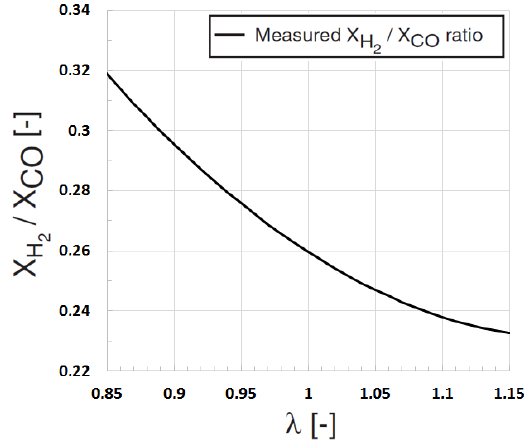
Figure 4. 𝐻 2 /𝐶𝑂 ratio. Empirical correlation from Holder et al. [17]. Figure 4. H 2 / CO ratio. Empirical correlation from Holder et al.